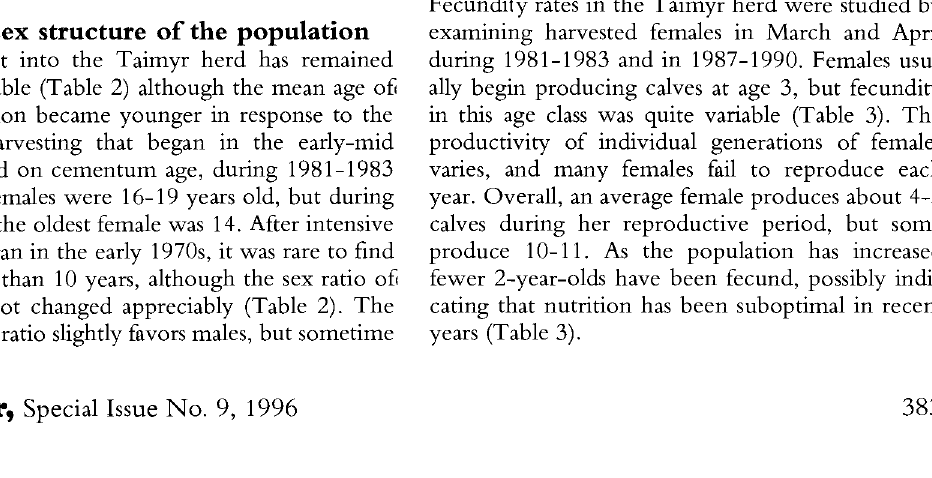
Table 3 . Fecundity in female wild reindeer harvested from the Taimyr herd in March and